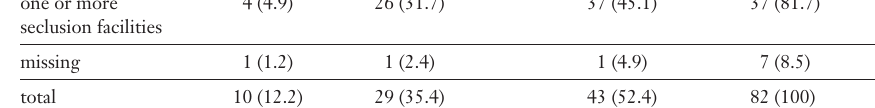
Facilities for seclu- sion with percent- ages of total number of wards (n =